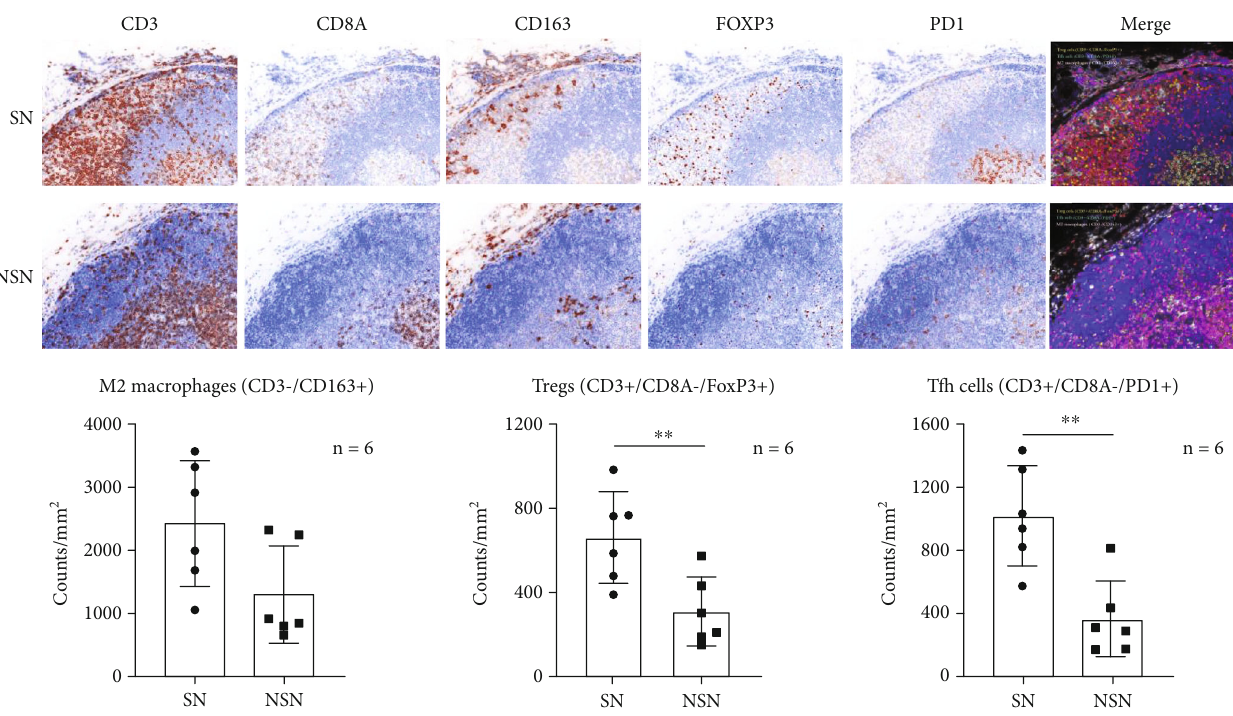
Figure 3: Spatial distribution and correlations of characteristic immune cell markers in lymph nodes. The expression of M2 macrophages (CD3-/CD163+), Tregs (CD3+/CD8A-/FoxP3+), and Tfh cells (CD3+/CD8A-/PD1+) is shown in the histogram. ∗∗ p < 0 : 01 .